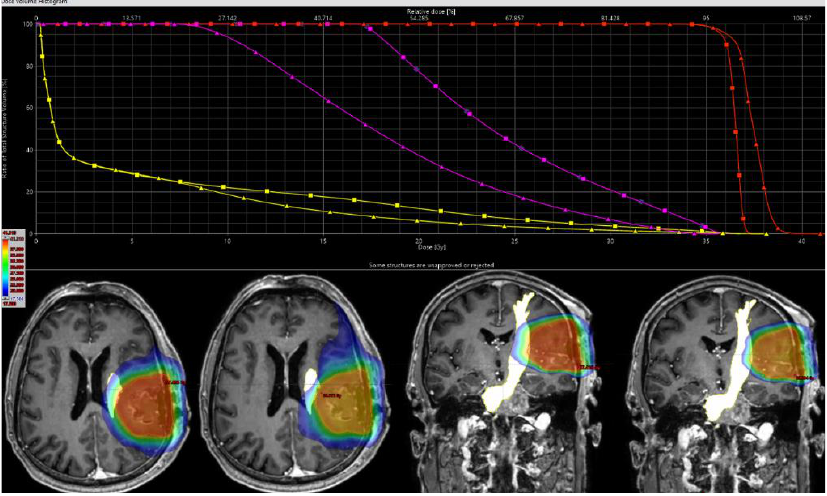
Figure 3. This figure illustrates the external beam plans for radiation therapy (RT) planning in one patient with a metastasis affecting the parietal lobe. The nTMS based DT-FT are seen delineated as organ at risk (FT mot.tms ) in yellow and PTV in red. Of note, there is a slight overlap of the PTV with FT mot.tms . Dose distribution is portrayed in dose color wash from high (red) to lower (green to blue) dose. Each of the left planar views show regular treatment planning without taking FTmot into account. On both the left axial and coronal slide dose distribution is shown for regular plans, each of the right planes depicts dose for optimized plans. The higher dose is drawn away from the fiber tract. On a dose-volume histogram (DVH), dose reduction is seen as a steeper gradient for FT mot.tms outside the PTV (FT mot exPTV) after optimization (yellow line, triangle), compared to the original RT treatment plan (yellow line, quadrate). Accordingly, the FT mot.tms areas beyond the PTV and within the 50% isodose line (FT mot exPTV 50% ) are displayed in magenta. DVH for PTV is equal up to a relative dose of 95%, but with a higher maximum dose (red